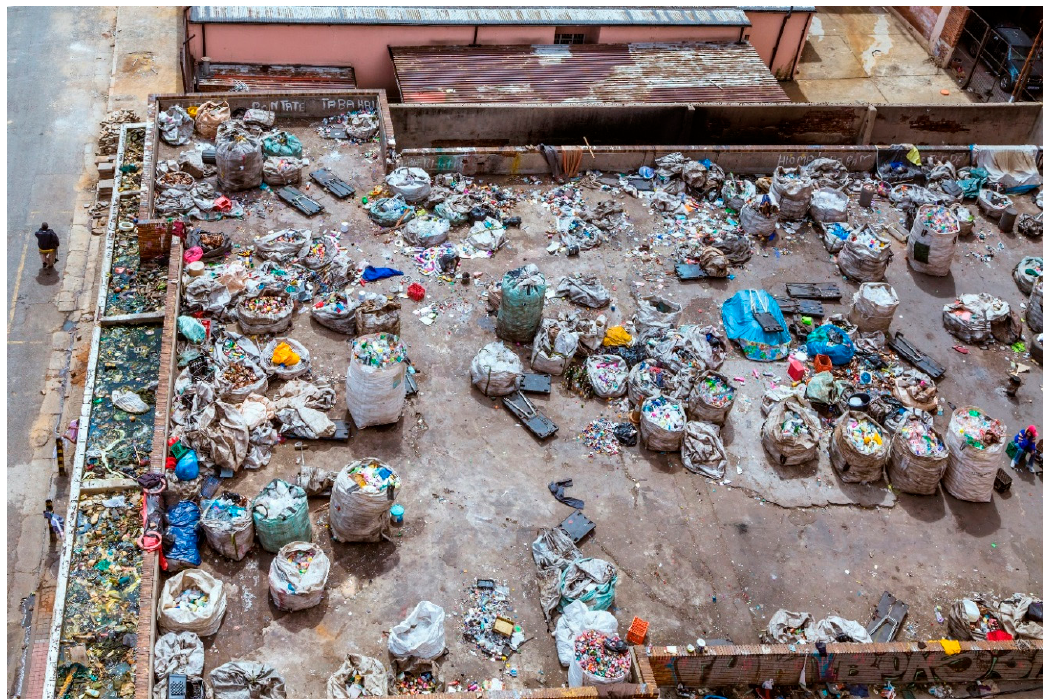
Figure 3. Informal sector contributions to recycling in Johannesburg, South Africa: Material collected in bags to be separated and transported to buyback centers (Photo credit: iStock photo/THEGIFT777, picture taken in March 2014).